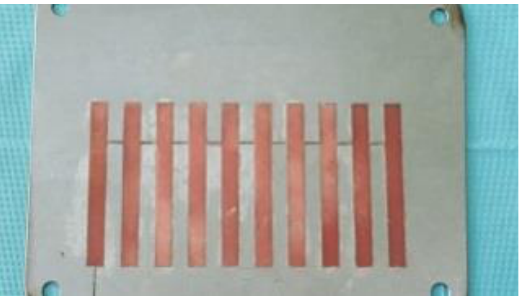
Figure 3: acrylic specimens in